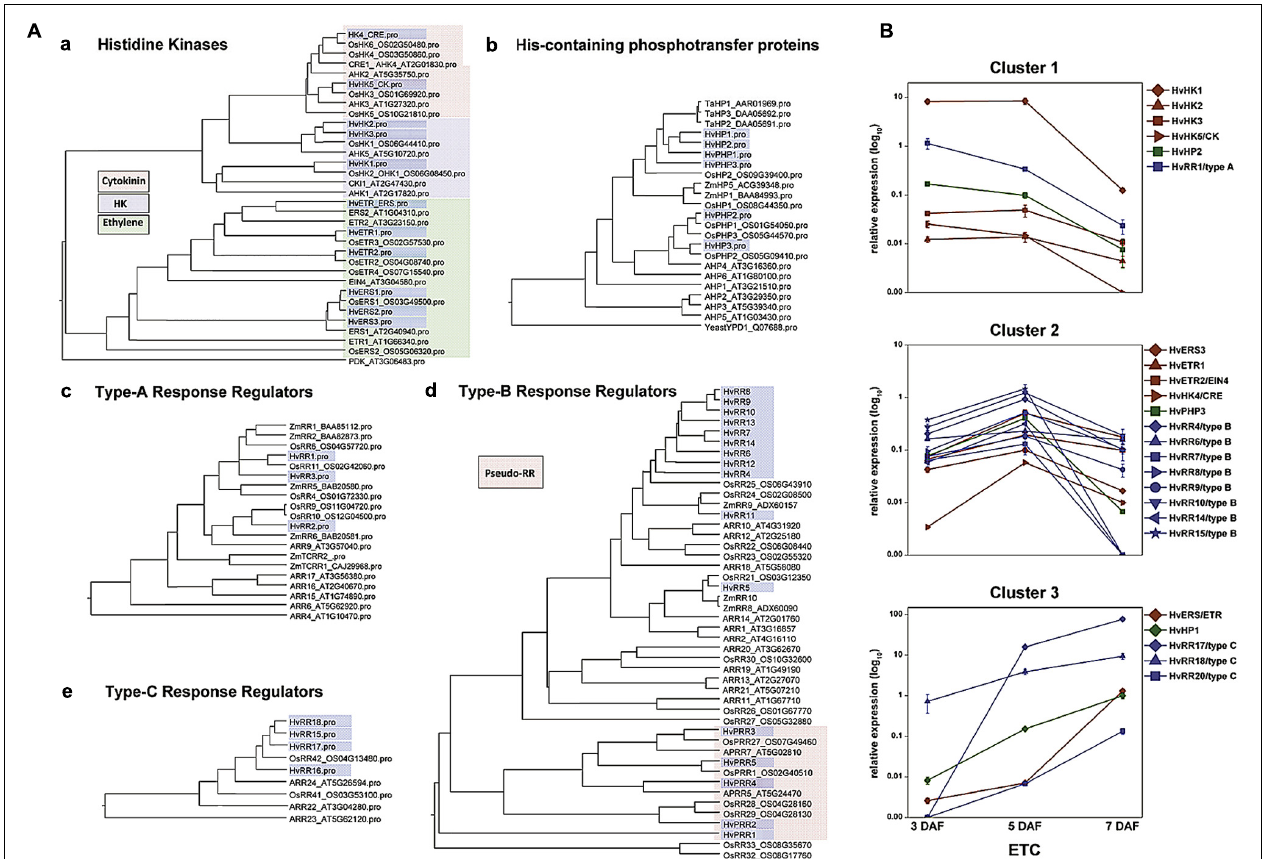
FIGURE 3 | Phylogenetic relationship ofTCS elements from barley, Arabidopsis and rice and expression profiles of selected genes in barley ETCs. (A) Barley sequences are highlighted by blue boxes. (a) Histidine kinases, colors indicate different subgroups. Arabidopsis PDK was used as outgroup. (b) HPt elements, protein sequences of Z. mays and T. aestivum were additionally included in the alignment.Yeast HPt proteinYPD1 was used